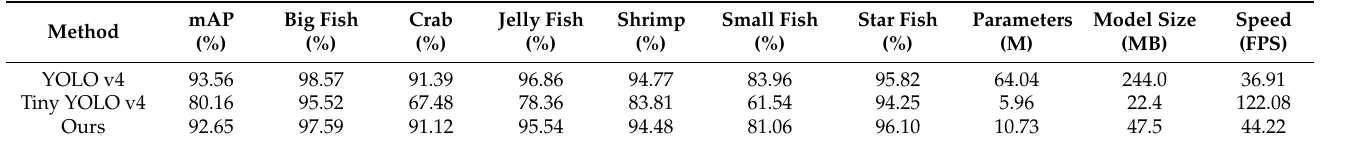
Table 7. Detection results of the proposed method on the brackish dataset.